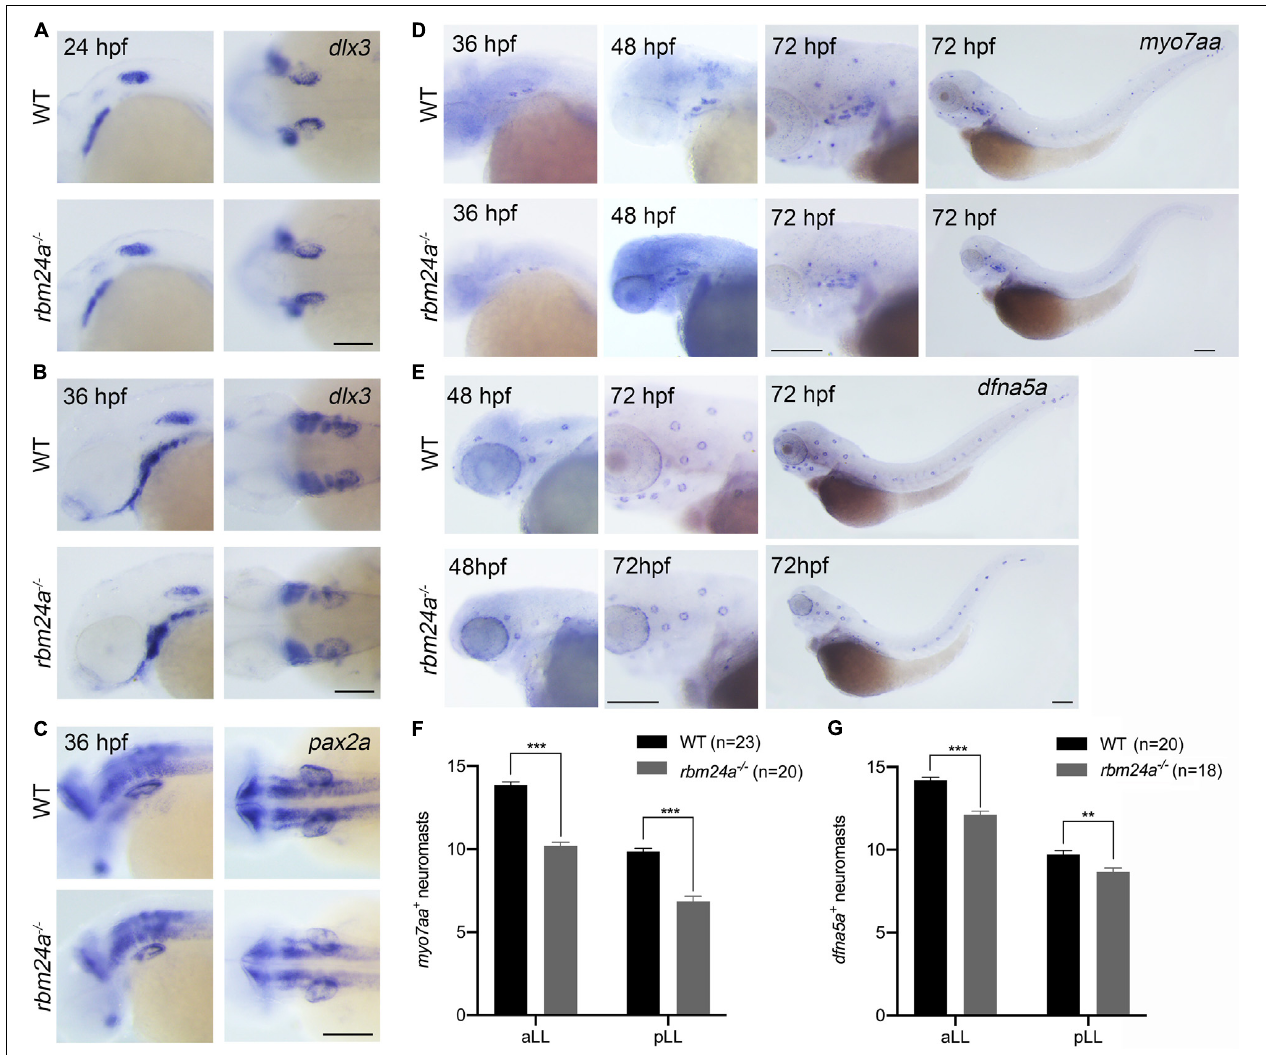
FIGURE 4 | Early inner ear development is largely unaffected in rbm24a mutants. Inner ear development is examined by performing in situ hybridization of dlx3 (A,B) , pax2a (C) , myo7aa (D) , and dfna5a (E) at different developmental stages as indicated. (F) The numbers of myo7aa + neuromasts are calculated according to the results from (D) . (G) The numbers of dfna5a + neuromasts are calculated according to the results from (E) . The numbers of larvae for each group are indicated in brackets. Scale bars, 0.2 mm. ** p < 0.01; *** p <